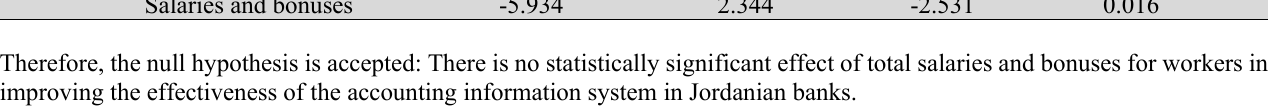
The effect of the third independent variable: Total salaries and bonuses for workers in Jordanian banks on the dependent variable Net profit after tax Independent variable Coefficient Std. Error Salaries and bonuses